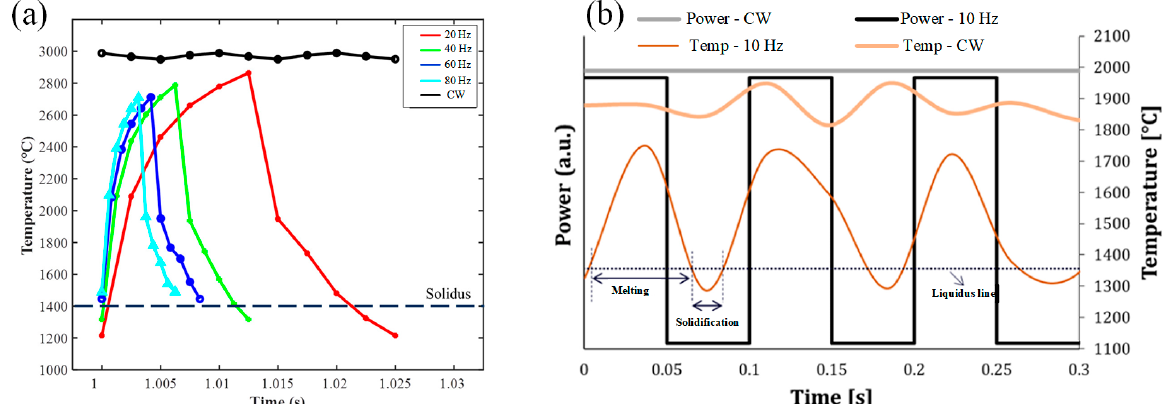
Figure 2. The temperature variation of molten pool by CW and PW temperature field based on ( a ) simulation (Reprinted from ref. [27], copyright (2021), with permission from Elsevier) and ( b ) experimental results where the peak power is constant (Reprinted from ref. [32], copyright (2020), with permission from Elsevier).